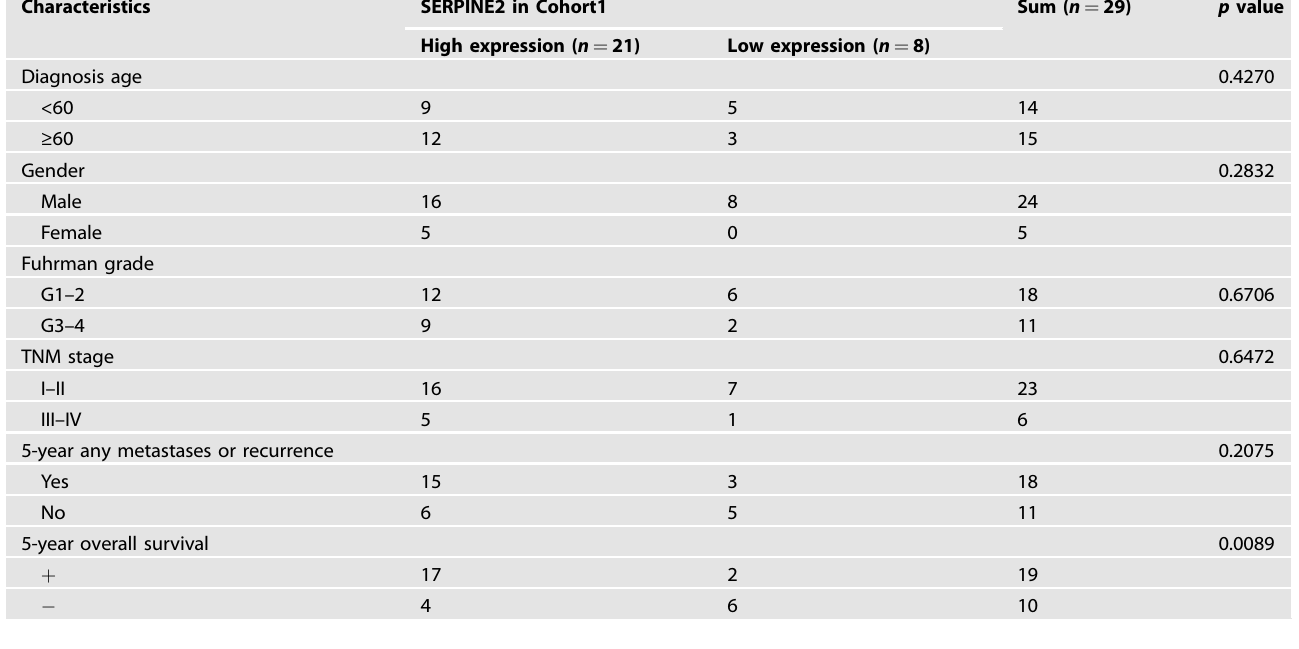
Table 1. Clinical characteristics of patients according to SERPINE2 expression a in Cohort1 ( n = 29). Characteristics